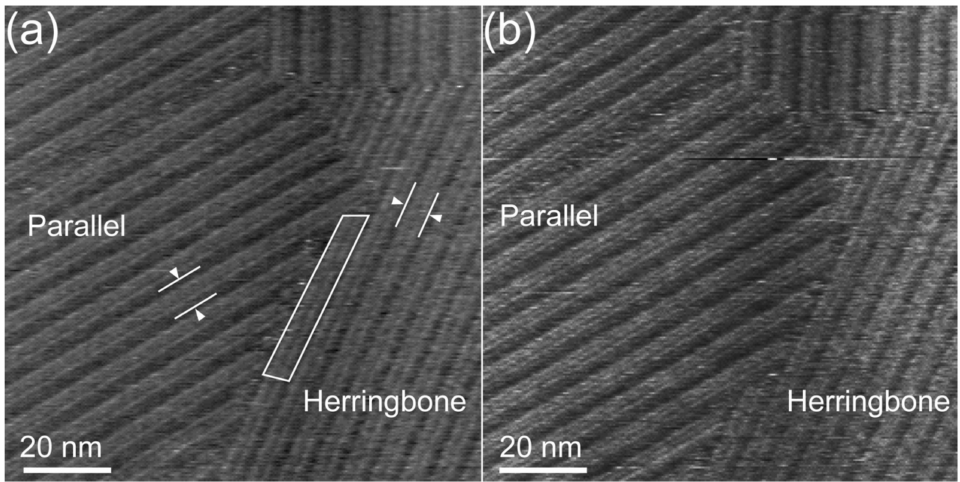
Figure 5. Successive STM images showing detailed features of the movement of the P/H interface by STM scanning ( I set = 10 pA, V bias = − 800 mV, 3.5 Hz). ( a ) The boundary between P and H domains is seen at the center of the image. ( b ) The part of the H domain surrounded by the white line in ( a ) becomes incorporated into the P domain on the left